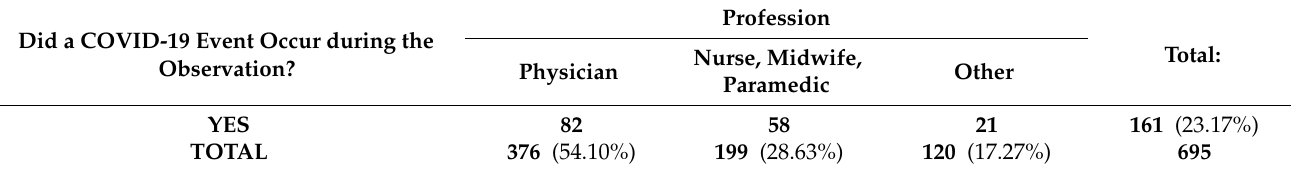
Table 14. The frequency of COVID-19 incidents by